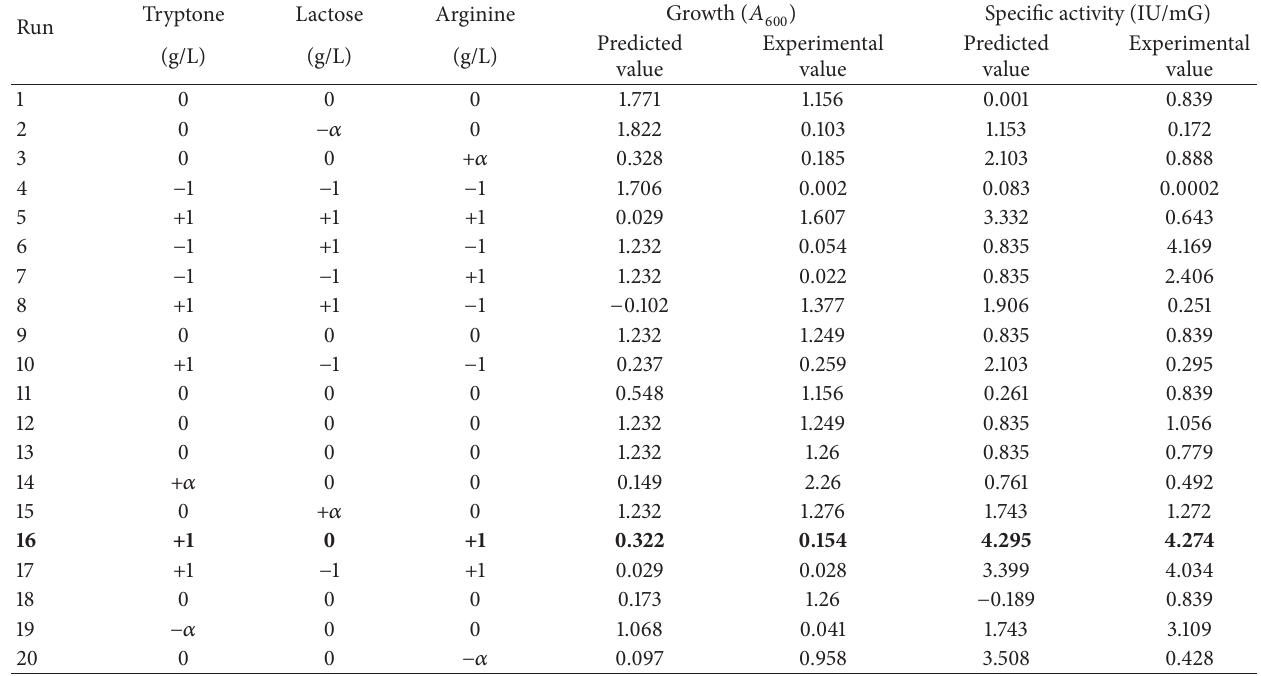
Table 2: Experimental design and results of central composite design for ADI specific activity and growth from E. faecium sp.